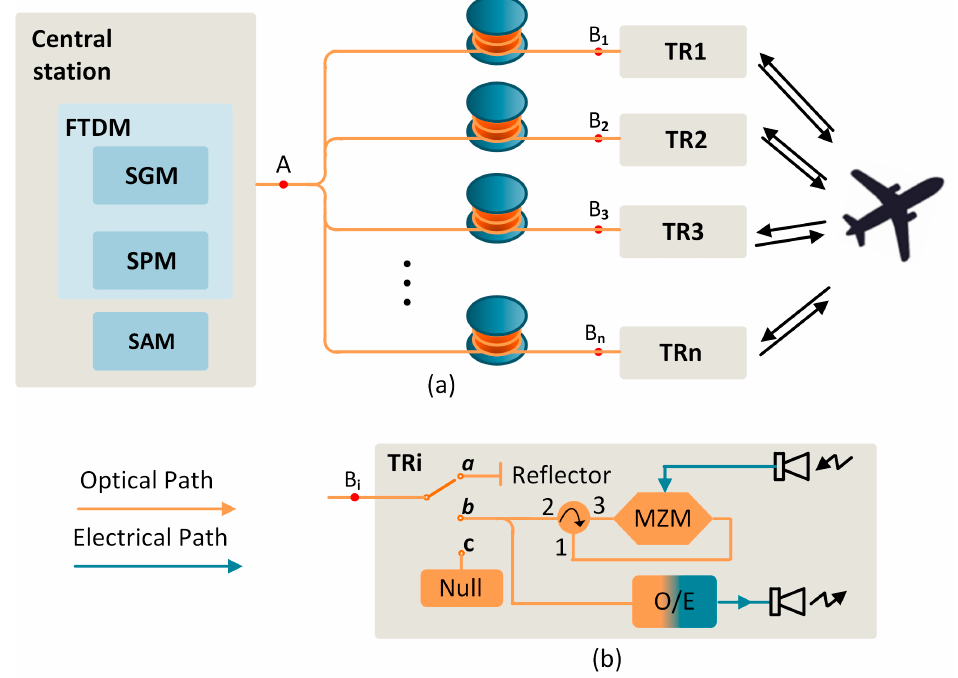
Figure 1. ( a ) An integration system of the proposed FTD measurement system with the distributed radar. ( b ) The diagram of TRi. FTDM, fiber transfer delay measurement system; SGM, signal generation module; SPM, signal process module; SAM, signal acquisition module; MZM, Mach–Zehnder modulator; O/E, opto-electrical converter.